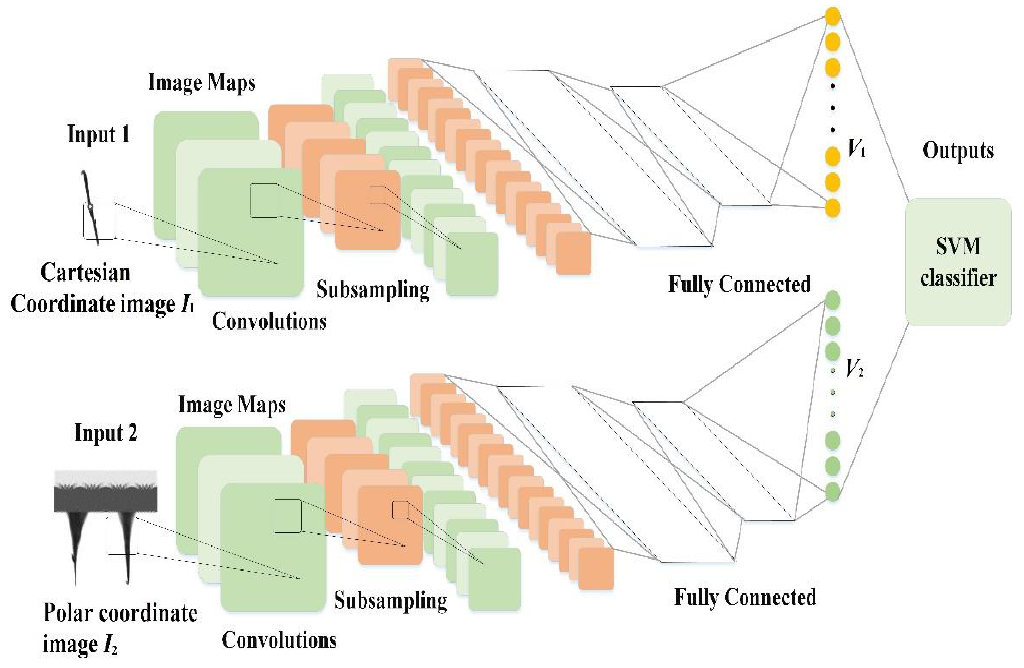
Figure 6. Structure of the proposed model. Note: SVM = support vector machine.